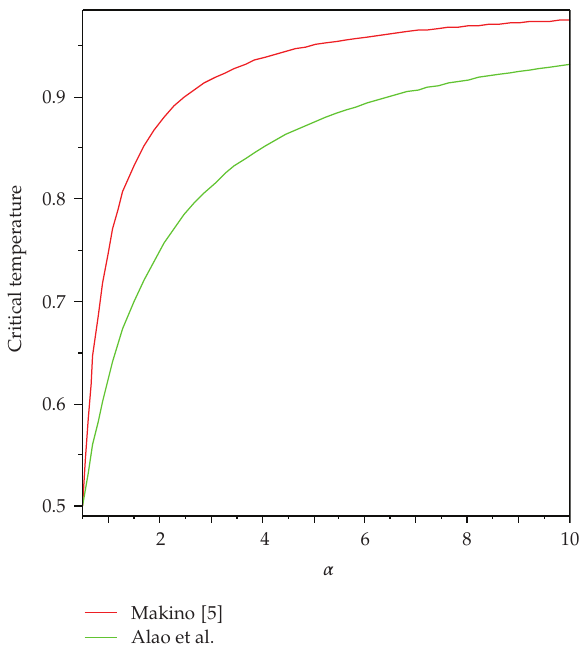
Figure 2: Comparison of critical temperatures: plot of (cid:3) 3.4 (cid:6) and (cid:3) 3.5 (cid:6)